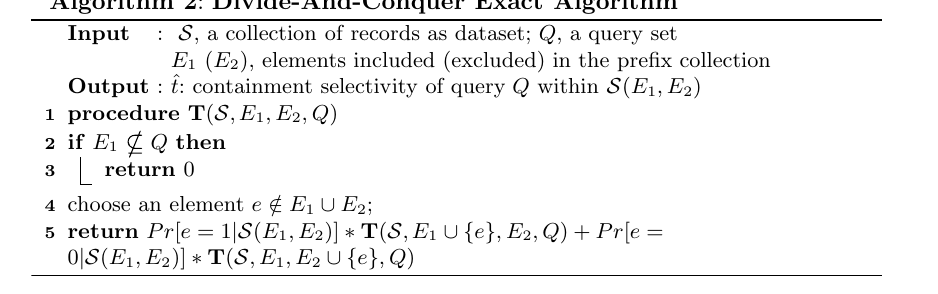
Algorithm 2 : Divide-And-Conquer Exact